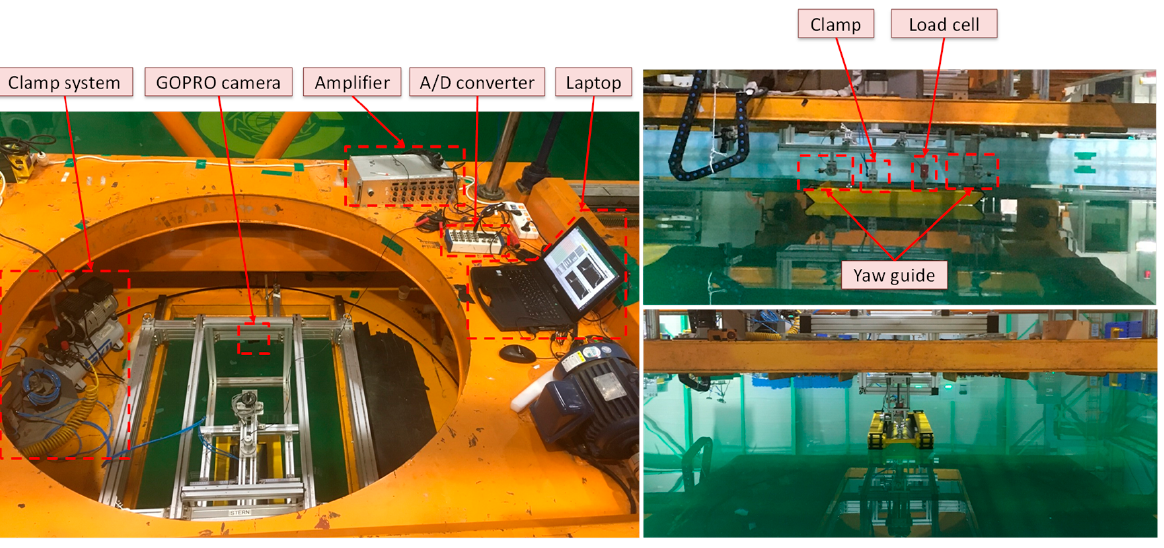
Figure 13. Result of load cell’s calibration. The model was towed at various ship speeds. However, because of the limit of the load cell calibration, the experiments were only capable to accommodate the model test up to Fn = 0.2 for the vessel with caterpillars and Fn = 0.25 for the vessel without caterpillars. The model test results are illustrated in Figure 14. Figure 14. Model test results of an amphibious vehicle w/and w/o caterpillars. 0.0 0.51.01.52.02.53.0 0.05